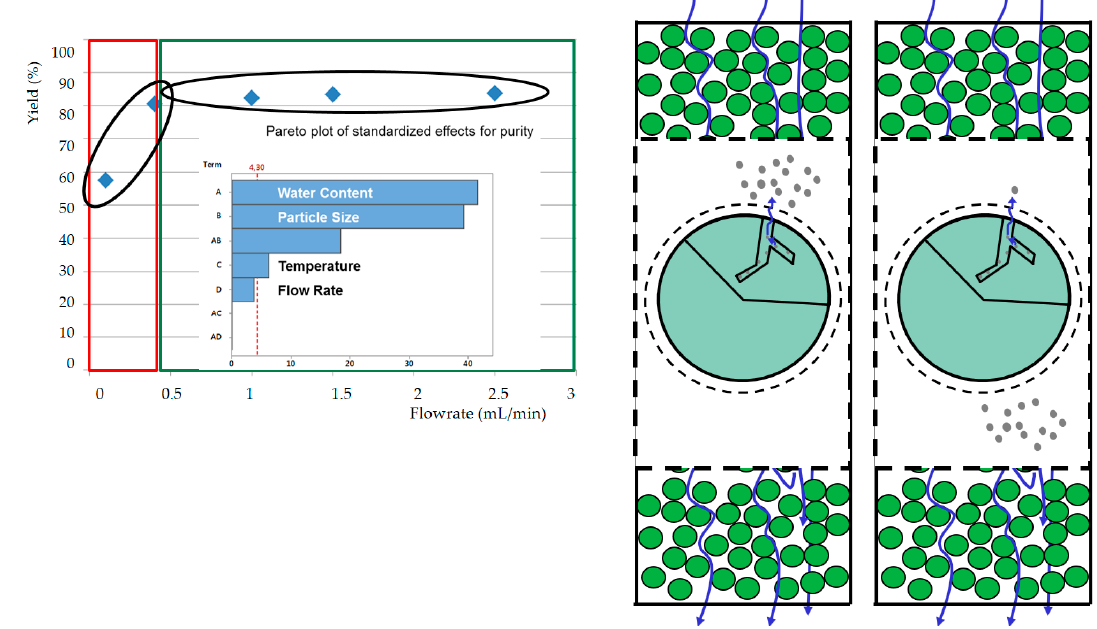
Figure 8. Residence time or solvent capacity limitation—maceration or percolation.